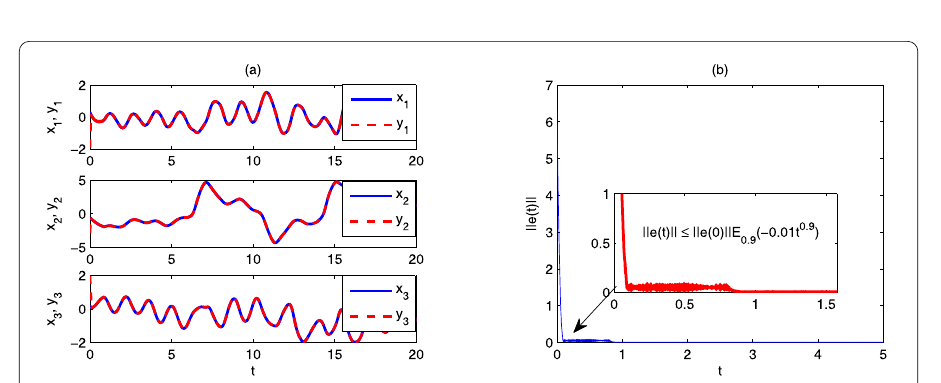
Figure 4 ( a ) State trajectories of drive–response systems; ( b ) time evolution of (cid:2) e ( t ) (cid:2) when controller (7) is